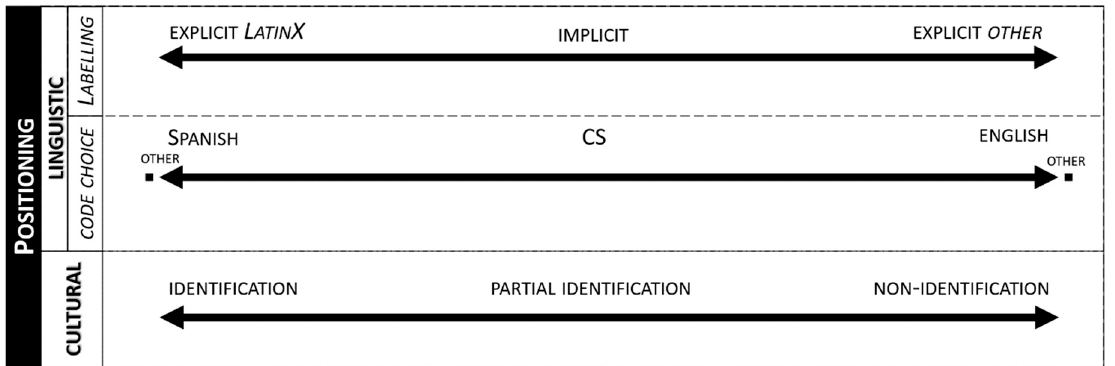
Figure 1. Continuum Model of Cultural and Linguistic Positioning.